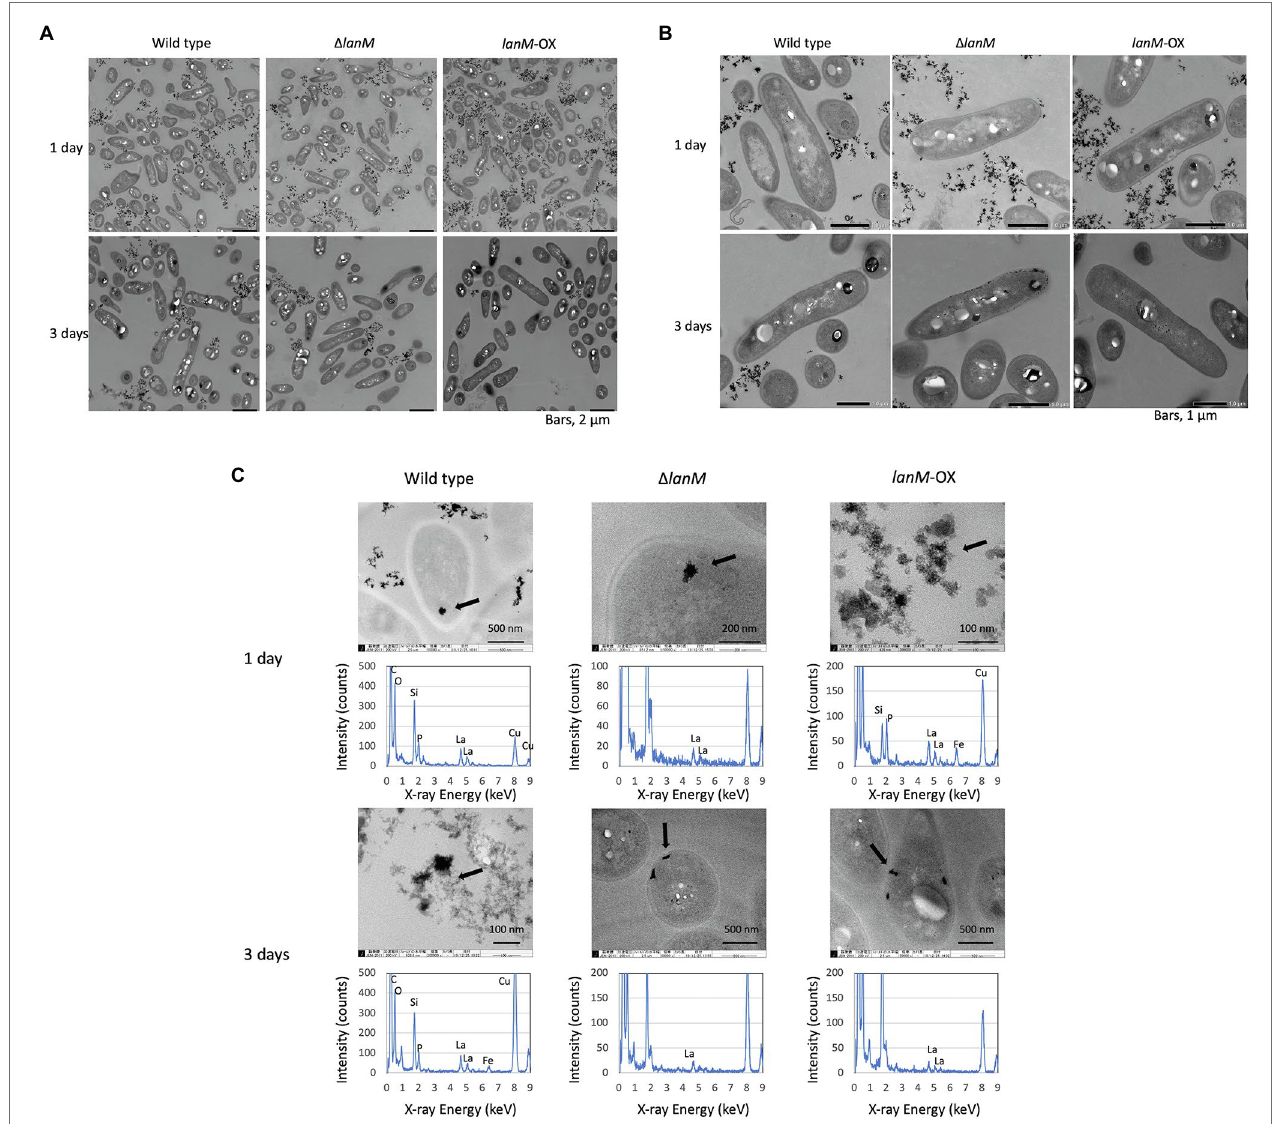
FIGURE 9 | TEM images of wild type, Δ lanM , and Δ lanM (pAT01-P fae1 - lanM ) grown in liquid mineral medium containing 0.5% methanol and 30 μ M La 3+ . (A,B) Cells stained with uranyl acetate and lead citrate. (C) EDX analysis for electron-dense particles observed in each sample. Arrows indicate the EDX-analyzed positions. The detected Si and Cu are derived from TEM lens tube and grids,